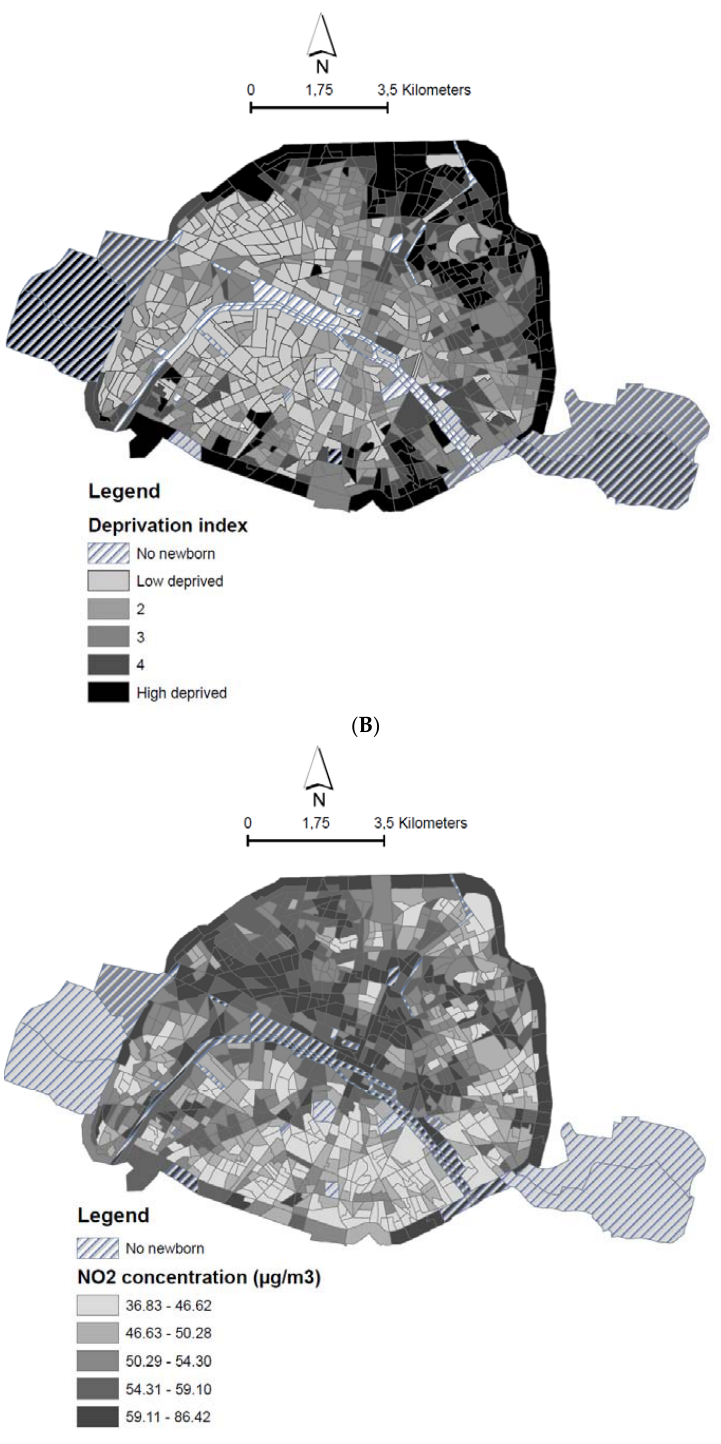
Figure 1. ( A ): Spatial distribution of crude preterm birth rate in census block areas within Paris; ( B ): Spatial distribution of socio ‐ economic deprivation index in census block areas within Paris; ( C ): Spatial distribution of NO 2 average concentrations from 2008 to 2011 in census block areas within Paris.